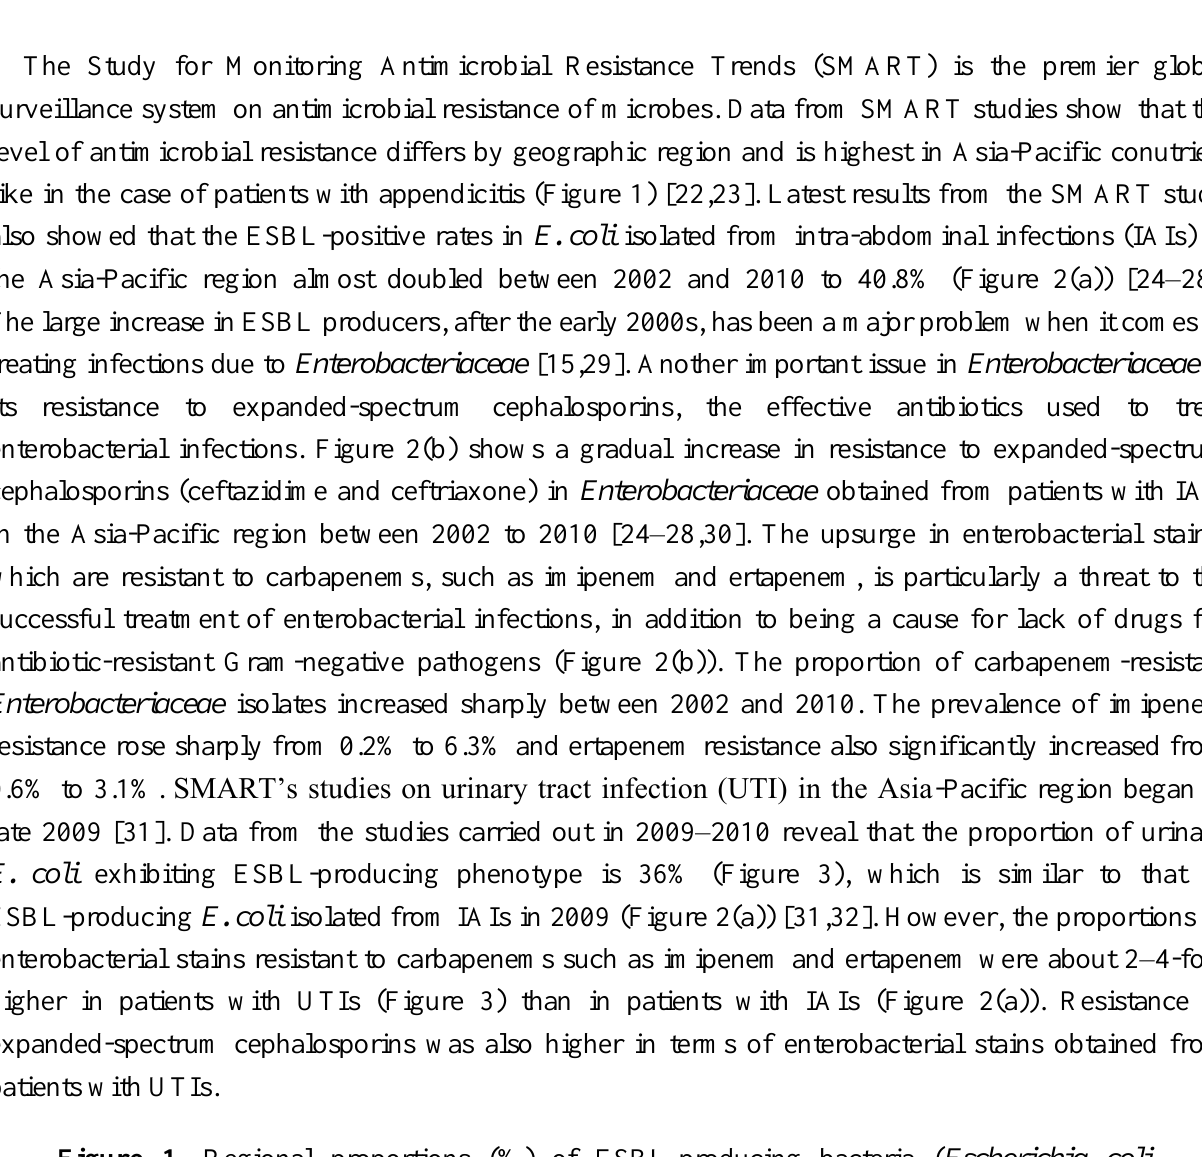
Figure 1. Regional proportions (%) of ESBL-producing bacteria ( Escherichia coli , Klebsiella pneumonia , Klebsiella oxytoca , and Proteus mirabilis ) isolated from patients with appendicitis: 2008–2010 results from the study for SMART with 95% confidence